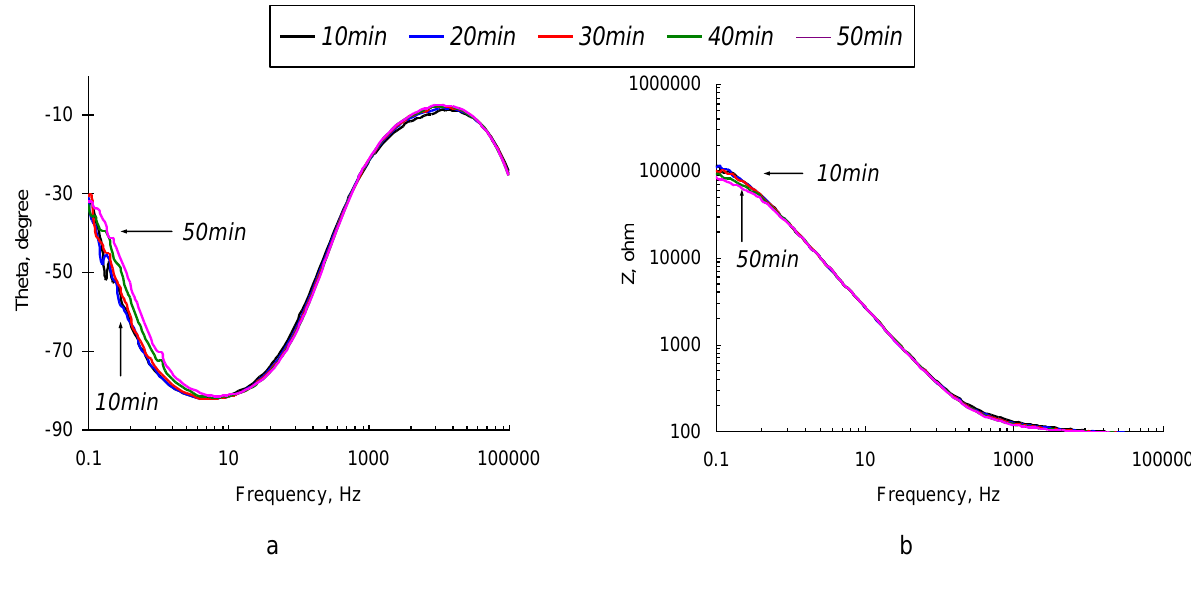
Figure 3. Phase angle (a) and impedance spectrum (b) of a non-polarized ( vs. Ag/AgC) SEB immunosensor in 10 μg/mL of SEB in 0.3% NaCl